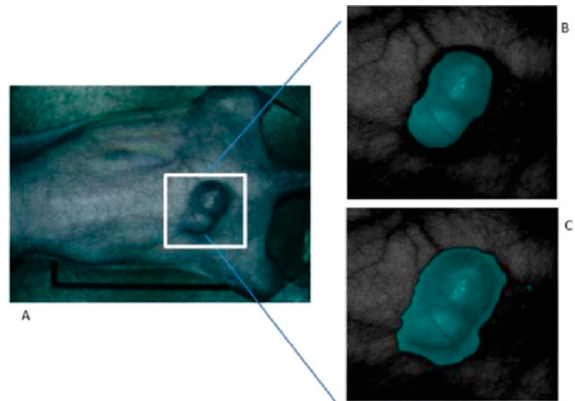
Figure 7. Result of the tumor identification using the Minimum-Spanning Forest method developed in [137]. ( a ) Synthetic RGB image of the original mouse; ( b ) Corresponding gold standard image; ( c ) Classification result obtained. Reproduced with permission from [137]; published by IEEE (2015).